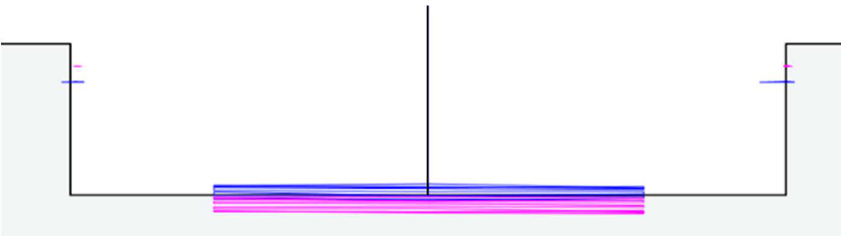
Figure 8. Front view measurements for Al and PUR 300.